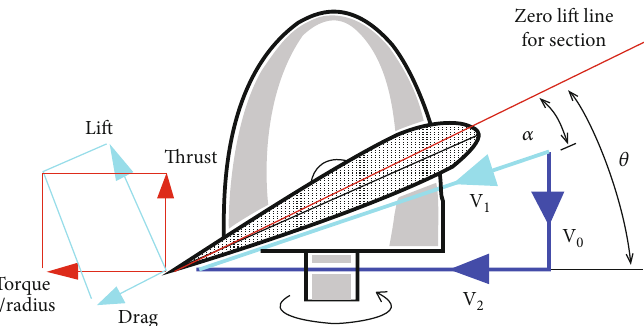
Figure 7: Resultant of force vectors and fl ow vectors [23].